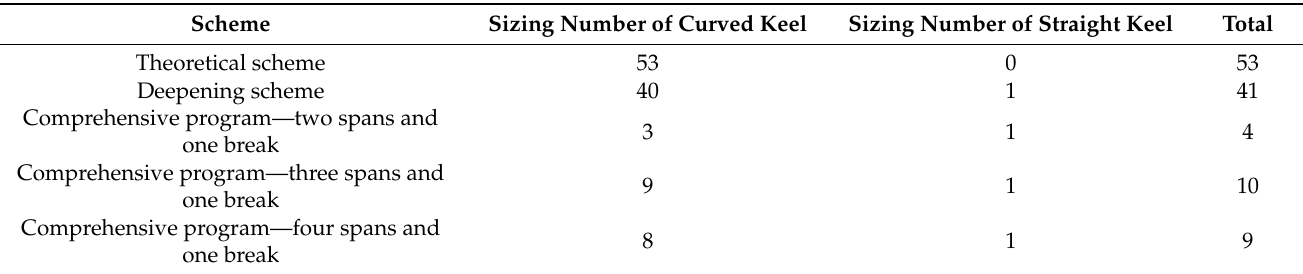
Table 14. Sizing quantity table of three